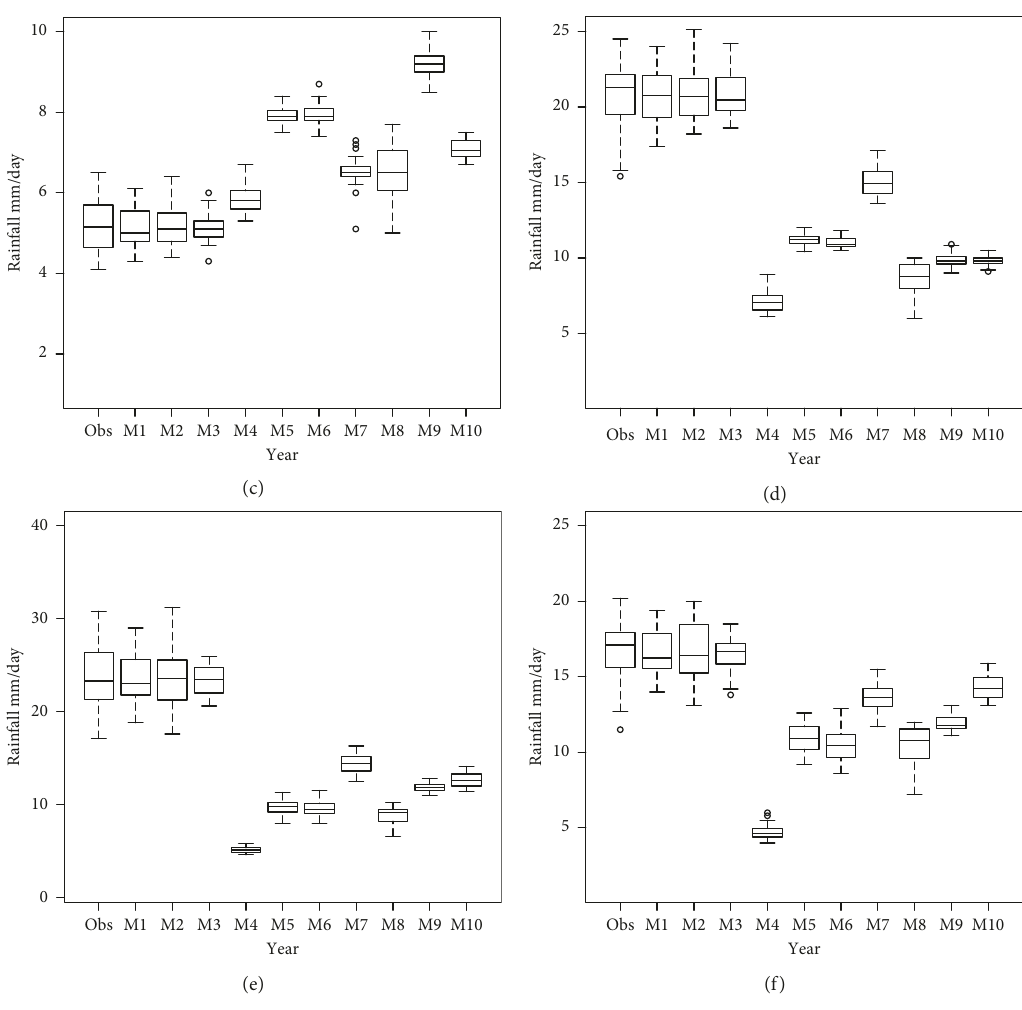
Figure 6: JJAS rainfall variability in observed (Obs, observed) and various model data (M1-AM-MME, M2-WA-MME, M3-PCRMME, M4- CCMv3.6, M5-ECHAM-CASST, M6-ECHAM-CFSSST, M7-CFSv2, M8-COLA, M9-GFDL, M10-ECMWF) for six zones of Myanmar: (a) shan, (b) north, (c) coastal, (d) dry, (e) south, and (f) delta.